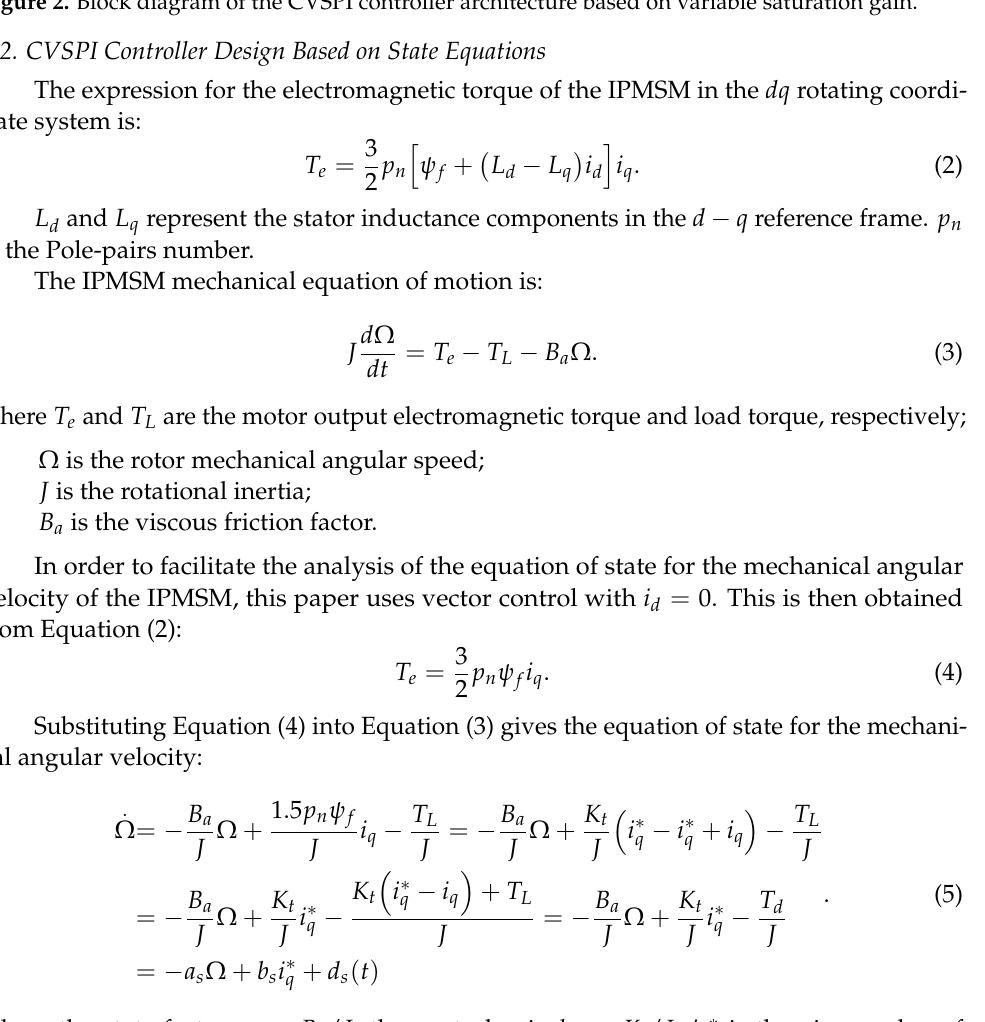
Figure 2. Block diagram of the CVSPI controller architecture based on variable saturation